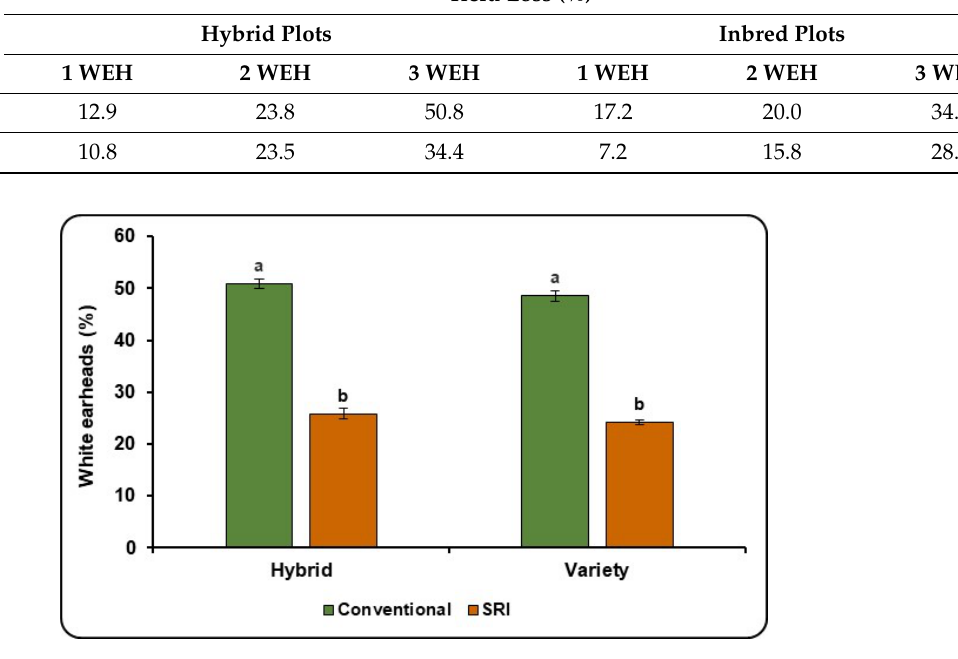
Figure 8. Incidence of white earheads in six cultivars. Means with the same letter are not significantly different by Tukey’s HSD ( p = 0.05) for each cultivarWhite earheads resulted in a significant reduction in grain yield, but more with conventional methods than with SRI methods. As expected, yield loss was greatest with three white earheads per hill for all the methods and for all of the cul ‐ tivars compared to having one or two white earheads per hill (Table 3). Table 3. Loss in grain yield (in %) associated with different densities of white earheads and rice cultivation methods.